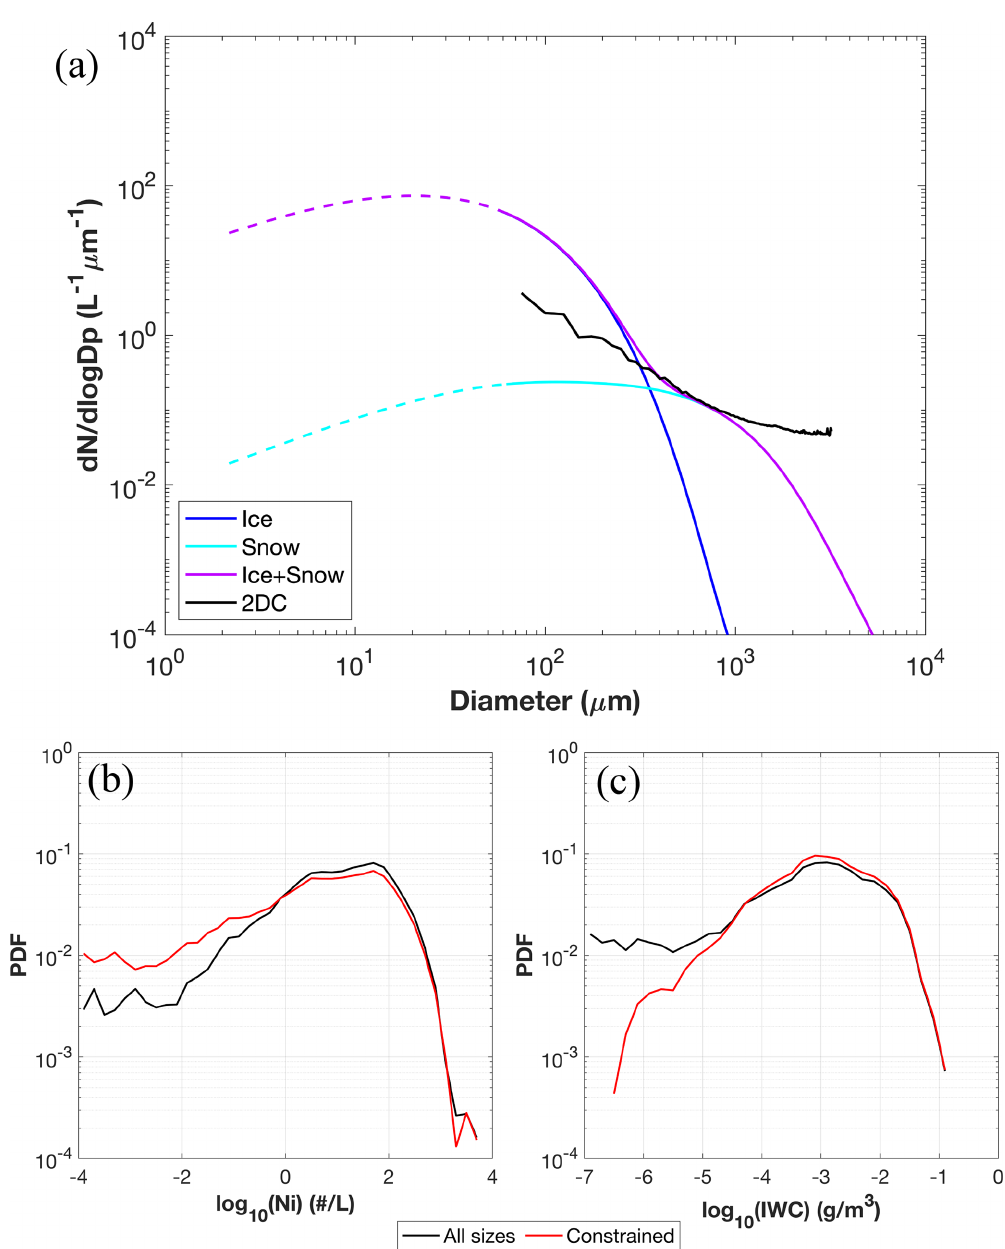
Figure 4. (a) Observed size distribution (black line) and reconstructed size distributions from simulated ice (blue) and snow (cyan). Size truncations to diameters < 62 . 5µm (dashed lines) are shown for simulated hydrometeors, while the remaining particles ( ≥ 62 . 5µm) (solid lines) are used for comparisons with observations. Size distributions for combined ice and snow in the simulations (purple) are also shown before and after the size restriction. Panels (b) and (c) show PDFs of N i and IWC in the simulation before and after size